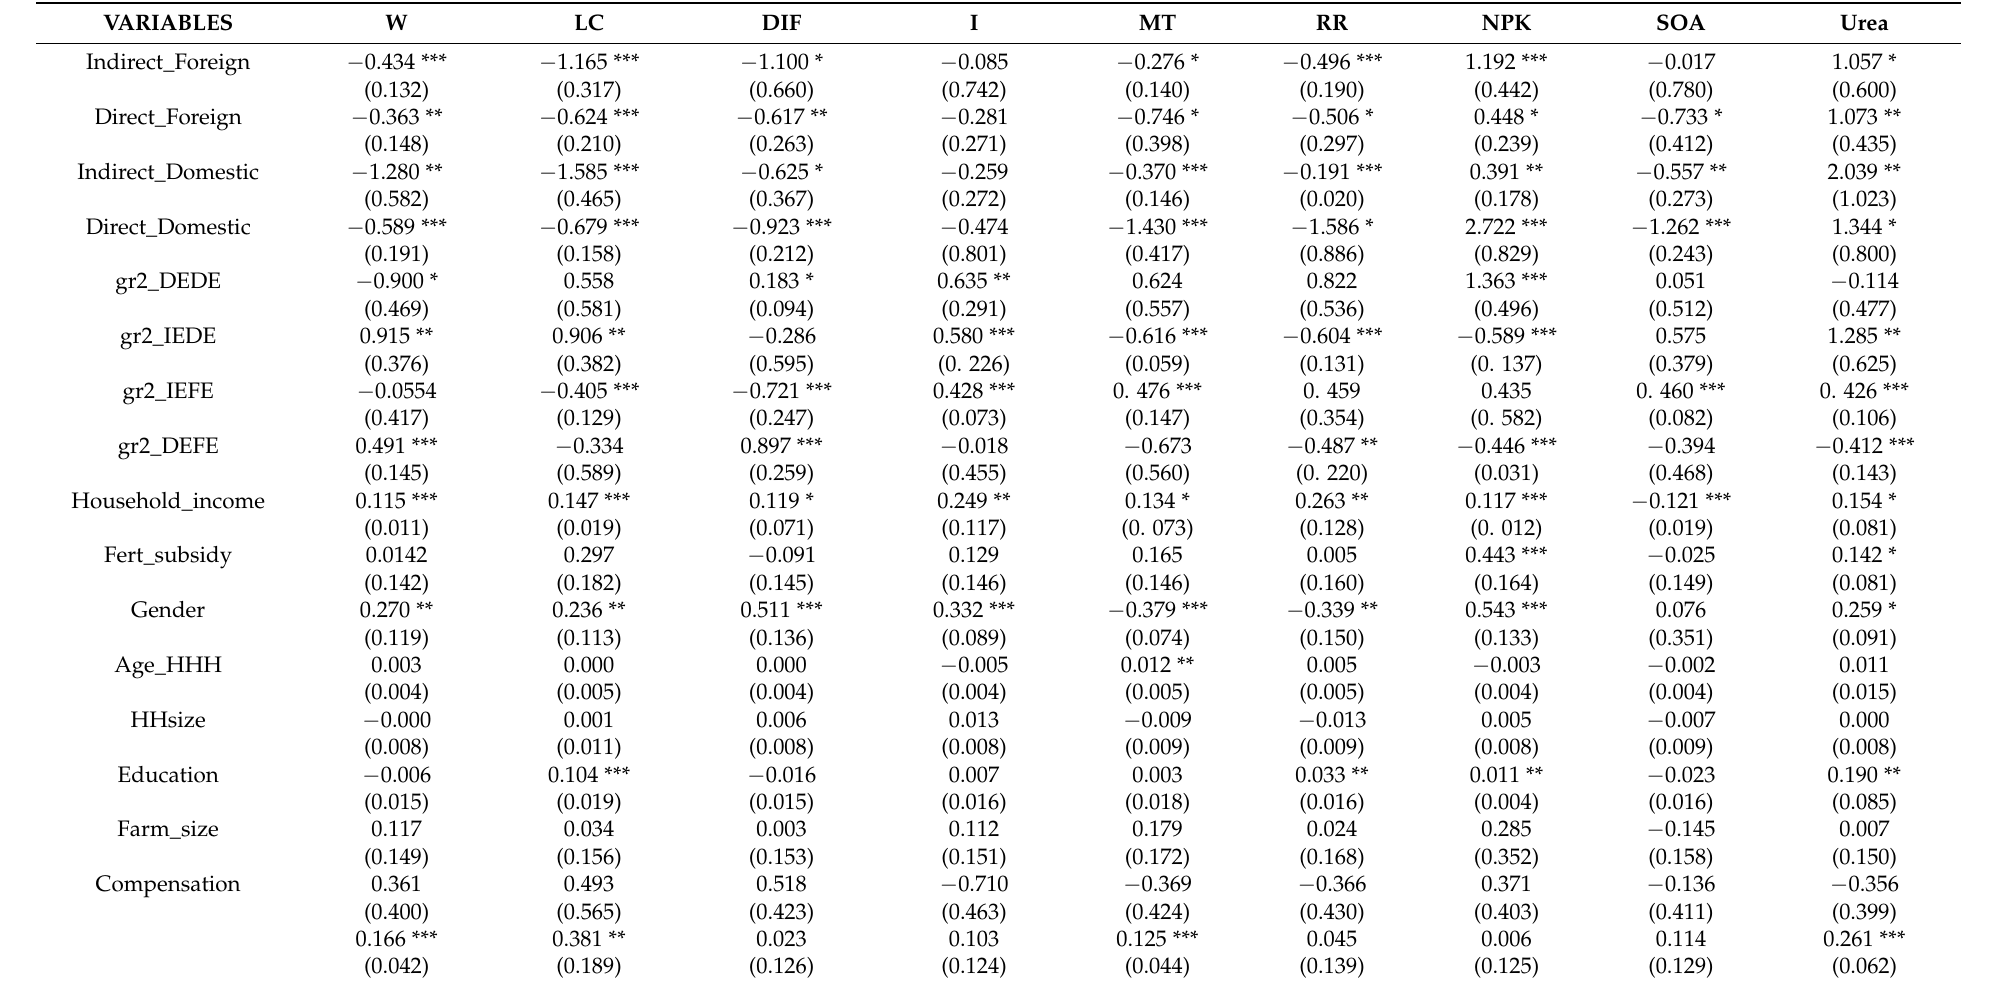
Table 5. Multivariate probit estimates of determinants of farm